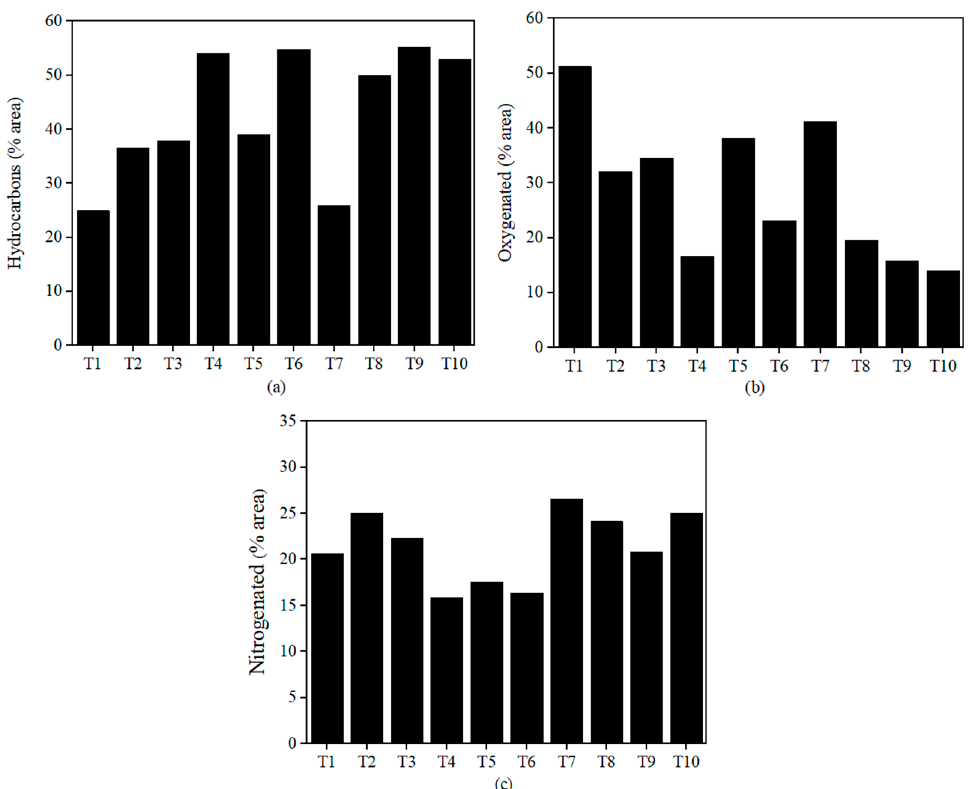
Figure 8. Semi-quantified percentages (% area) of hydrocarbons ( a ), and oxygenated ( b ) and nitrogenous compounds ( c ) found in bio-oil in each solar pyrolysis test.